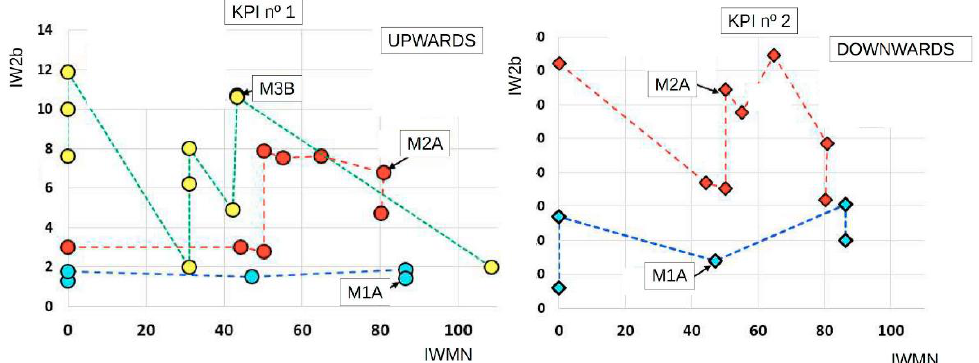
Figure 7. Graphs of the values of KPI N ◦ 1 ( left ) and KPI N ◦ 2 ( right ) corresponding to the machines whose data were analyzed.